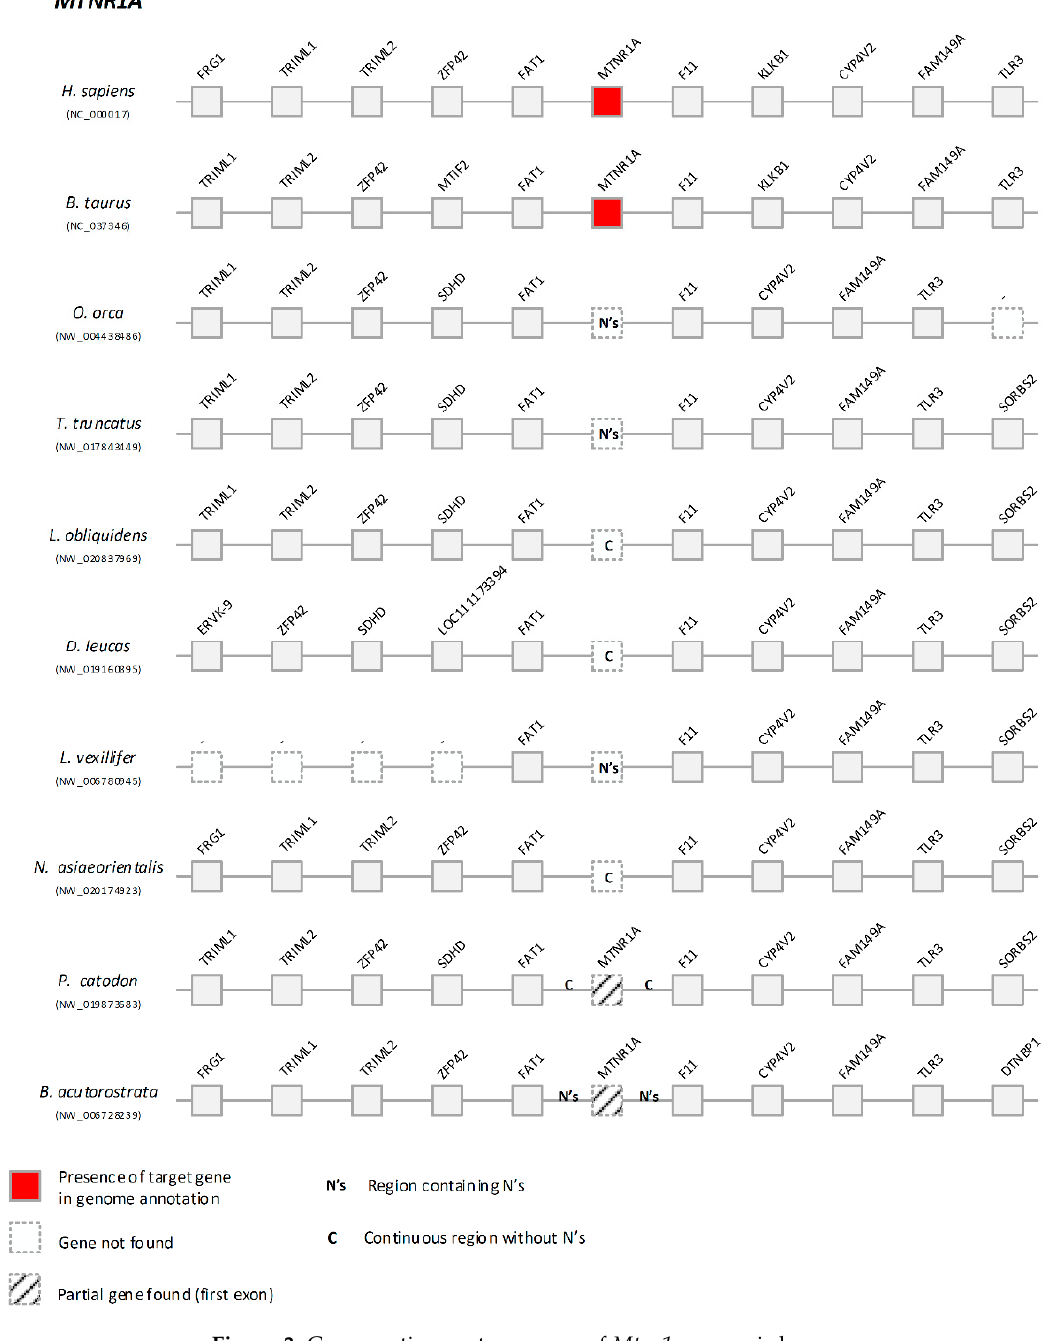
Figure 3. Comparative synteny maps of Mtnr1a genomic locus.